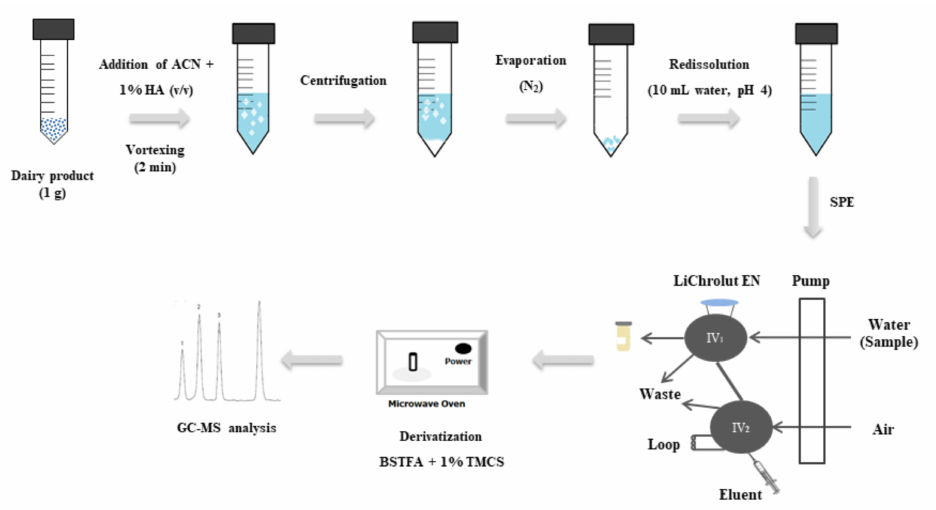
Figure 1. Procedure for determining endocrine disrupting chemicals in dairy products. BSTFA N , O - bis (trimethylsilyl) trifluoroacetamide; GC–MS gas chromatography–mass spectrometry; IV injection valve; SPE solid-phase extraction; TMCS